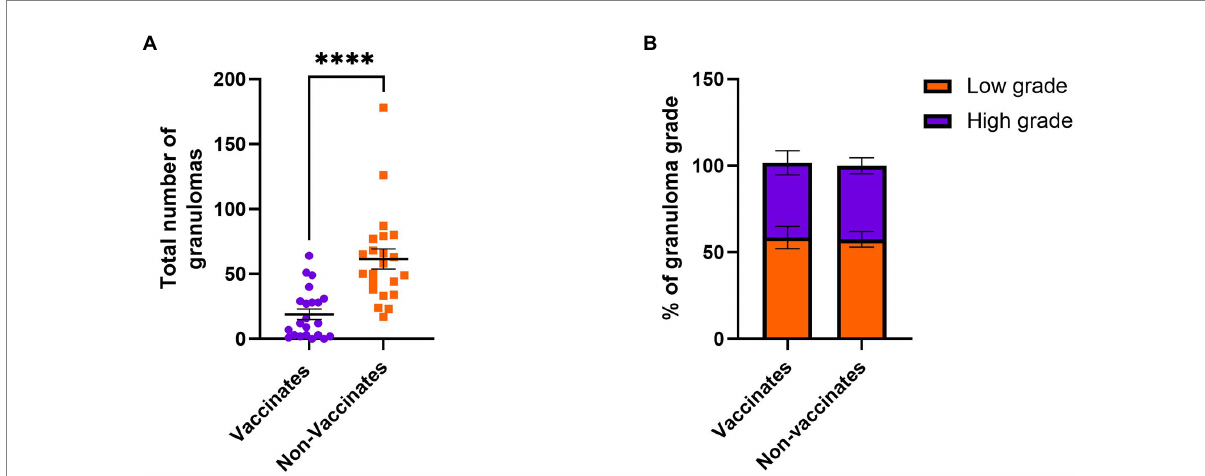
FIGURE 2 Absolute numbers of granulomas in BCG-vaccinated and non-vaccinated cattle infected with M. bovis and percentage of each granuloma grade. (A) The total number of granulomas present in vaccinates and non-vaccinates, respectively. Each dot represents one animal and the combined total of granulomas in its mediastinal and tracheobronchial lymph nodes. (B) the relative percentages of high- and low-grade granulomas. Values are presented as means ± SEM (****value of p < 0.0001).